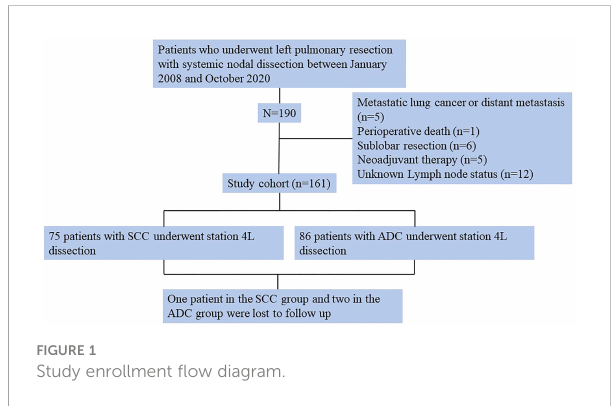
FIGURE 1 Study enrollment fl ow